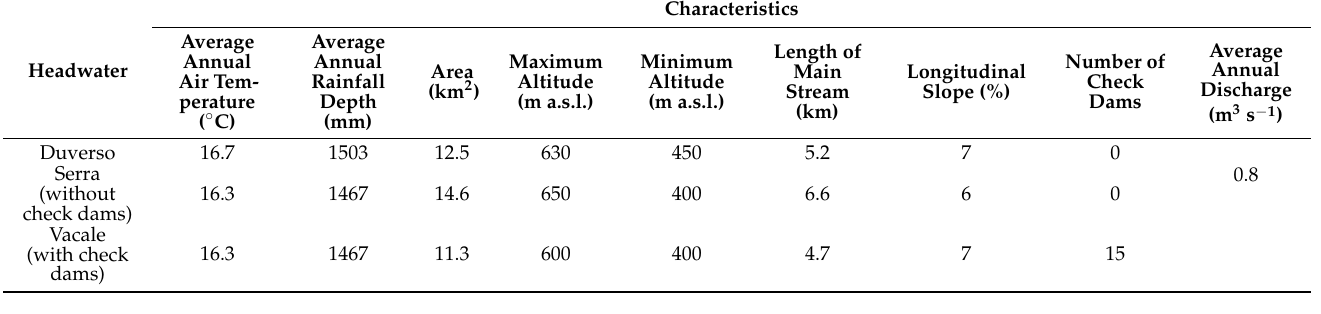
Table 1. Main characteristics of the selected headwaters (Duverso, Serra, and Vacale torrents, Calabria, Southern Italy).